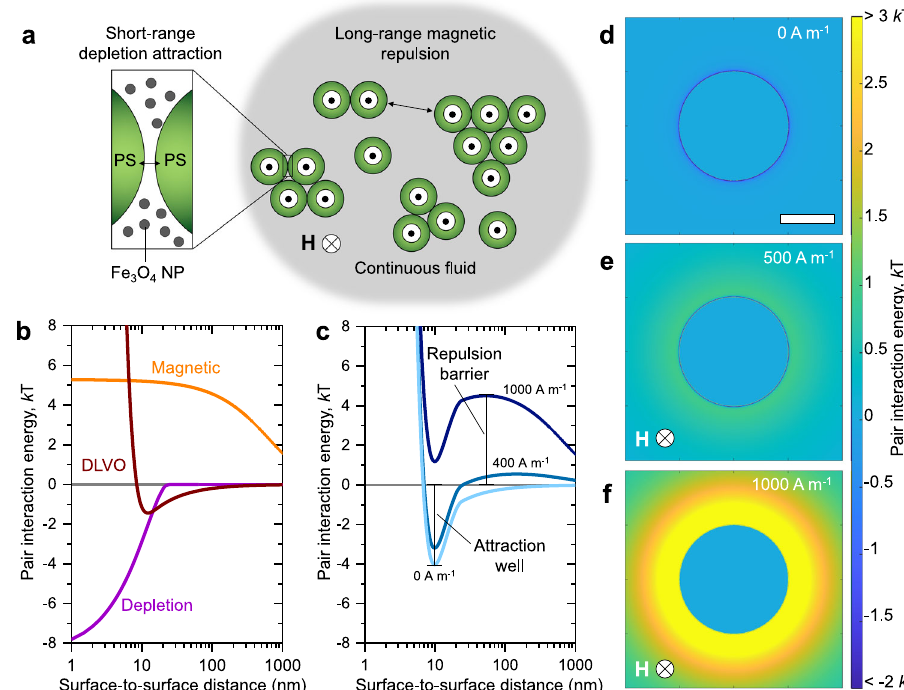
Fig. 4 Theoretical background. a Schematic of the discrete and continuous nature of MNP dispersions. Individual Fe 3 O 4 NPs act as depletants while the magnetic fl uid renders microparticles diamagnetic in an out-of-plane external magnetic fi eld. b Pair interaction energy contributions of electrostatic-van der Waals (DLVO), depletion and magnetic interactions. c Plots of total pair interaction energy with differing contribution of magnetic repulsion. As the fi eld strength increases, the net interaction switches from attractive to repulsive indicating the role of the magnetic contribution in morphing the energy landscape in favor of assembly or disassembly. d – f Color maps representing the distribution of interaction energy surrounding a microparticle with an out- of-plane fi eld intensity respectively 0, 500, and 1000 A m − 1 . Scale bar: 1 μ